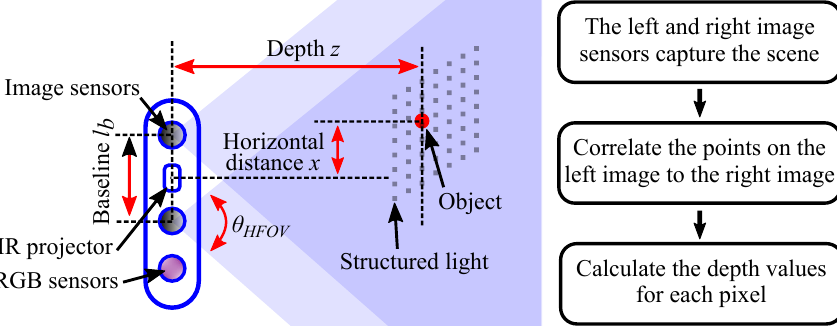
Figure 2. The depth perception based on active infrared stereo vision